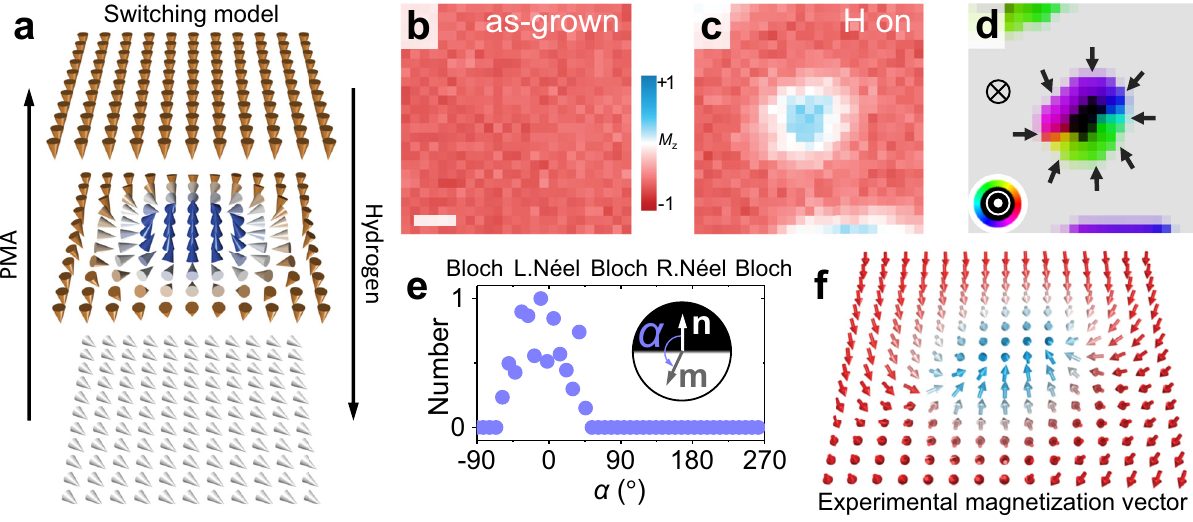
Fig. 2 Hydrogen-induced skyrmion writing. a Perspective sketches of magnetization near spin reorientation transition in Ni/Co/Pd/W(110). b SPLEEM image of Ni/Co/Pd/W(110) (near SRT) on a local − M z domain. Scale bar is 100 nm. c SPLEEM image at the same place as in panel b after 0.9 Langmuir hydrogen exposure, showing a bubble-like domain with + M z . d Compound SPLEEM image resolving the bubble-like domain as a skyrmion. Black/light gray represent up/down magnetization of the perpendicularly magnetized domains (see symbols), respectively, and color wheel shows in-plane magnetization direction within domain walls (also shown by black arrows). e Histogram of angle α between magnetization m and boundary normal n , measured pixel-by- pixel along domain boundaries, indicating left-handed chiral Néel walls. f Experimentally determined arrows-array representation of the skyrmion structure over a 200 ´ 200nm 2 area, each arrow shows the magnetization vector direction of one pixel in panel d